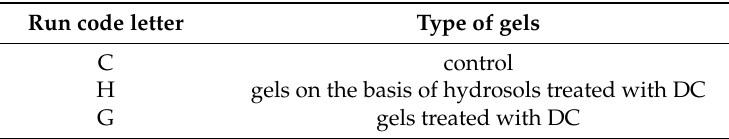
Table 2. Types of